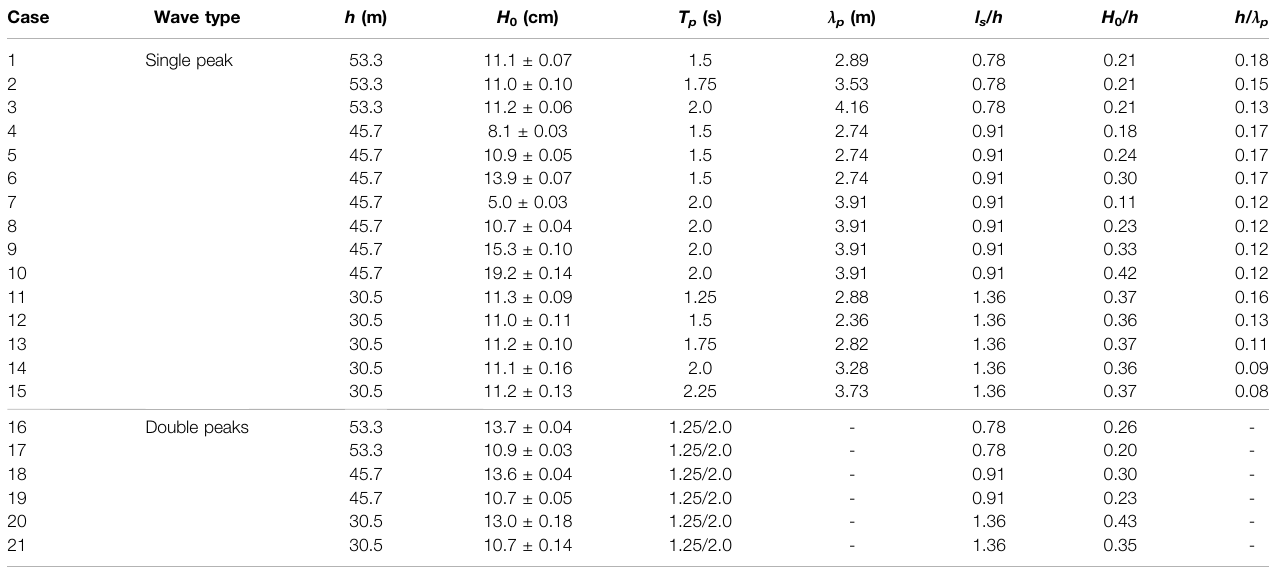
TABLE 1 | Wave condition at the beginning of vegetation zone (5th gauge from